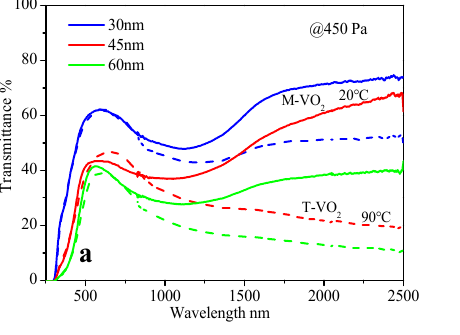
Figure 2. ( a ) Transmittance of VO 2 films prepared by professional annealing of V metal films with different thicknesses at 450 Pa. ( b ) Transmittance of VO 2 films prepared by professional annealing of 45 nm V films at different pressures; all at 400 °C for 1 h; solid line: 20 °C (monoclinic M-VO 2 ), dashed line: 90 °C (tetragonal T-VO 2 ). Table 4. Optical properties of VO 2 thin films prepared by professional annealing under optimized thickness and pressure.